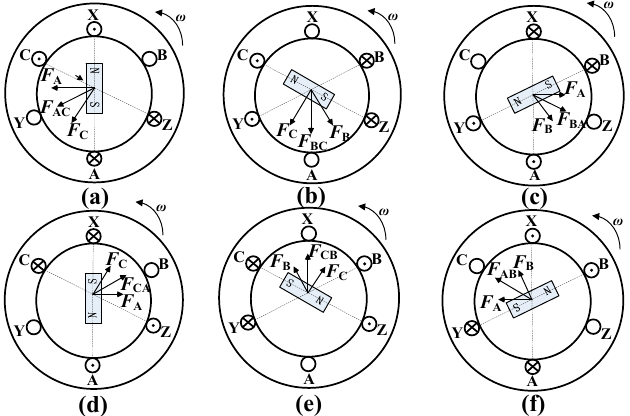
Figure 2. Schematic diagram of stator winding conduction and synthetic flux.